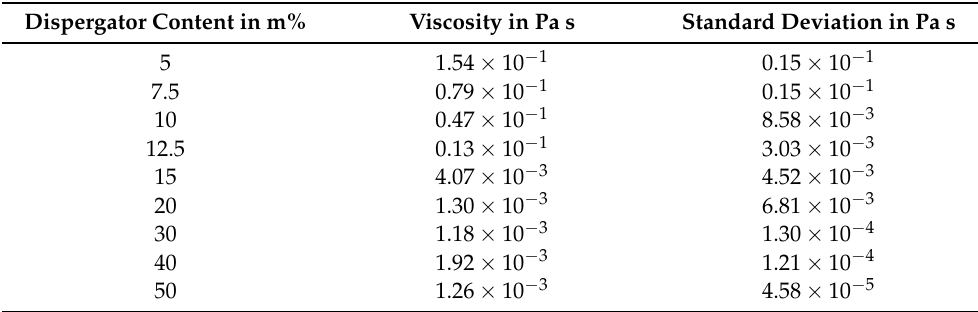
Table A11. Viscosity values as a function of PVP content for an aqueous dispersion containing 10 m% graphite nanoparticles at a pH value of 7.8.